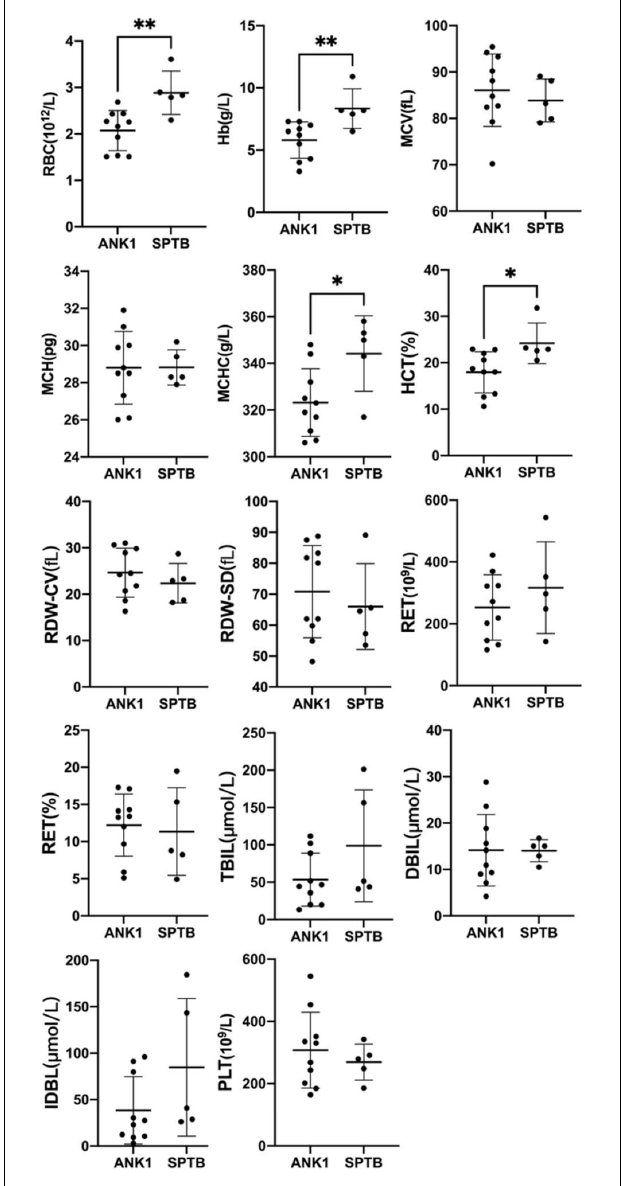
FIGURE 2 | Comparison of Hb, RBC, MCV, MCH, MCHC, and other indicators between the two groups of 15 patients in our hospital. ∗ p < 0.05, ∗∗ p <